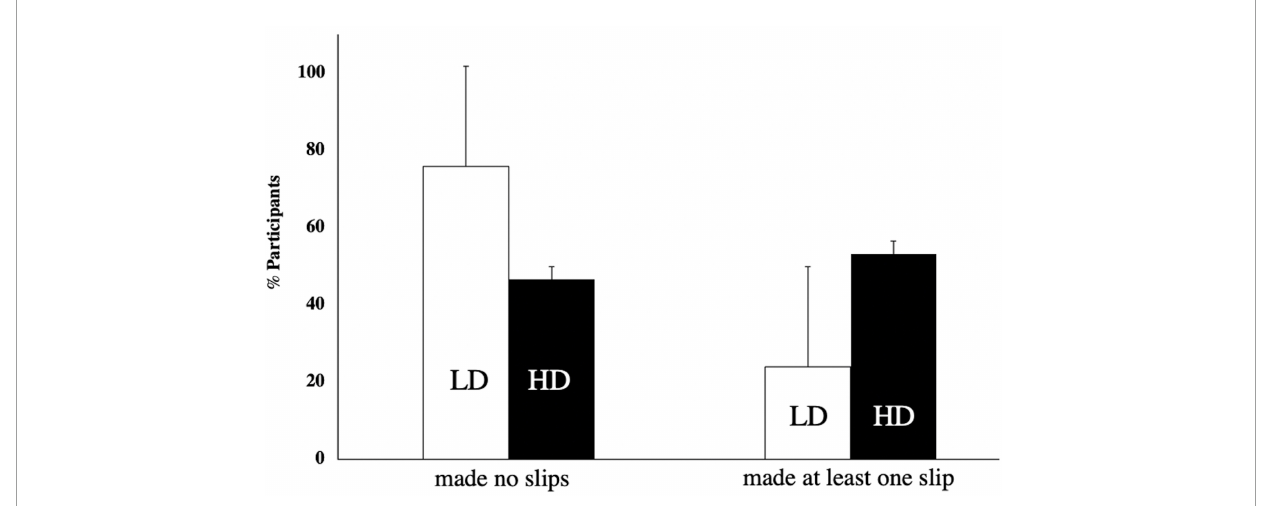
FIGURE3 Main behavioral effects: percentage of number of lowly ( N total = 25) and highly ( N total = 30) defensive participants who made no slips versus at least one slip ( χ 2 ( 1 ) = 4.889; p = 0.027; the χ 2 test indicates that the total correlation between “making no or at least one slip” and “being lowly or highly defensive” is